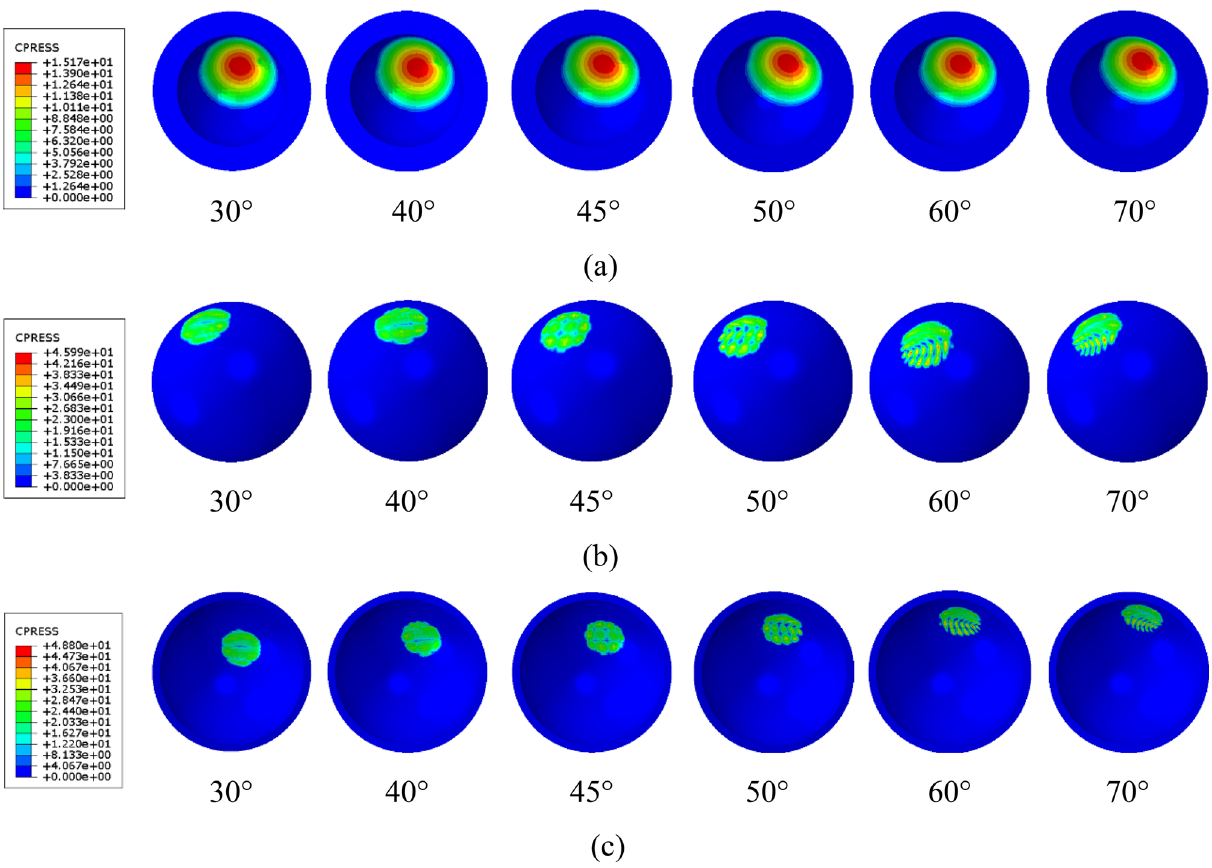
Figure 5. Contour plot of contact pressure on current dual-mobility hip joint prosthesis components: ( a ) inner surface of inner liner, ( b ) outer surface of outer liner, ( c ) inner surface of acetabular